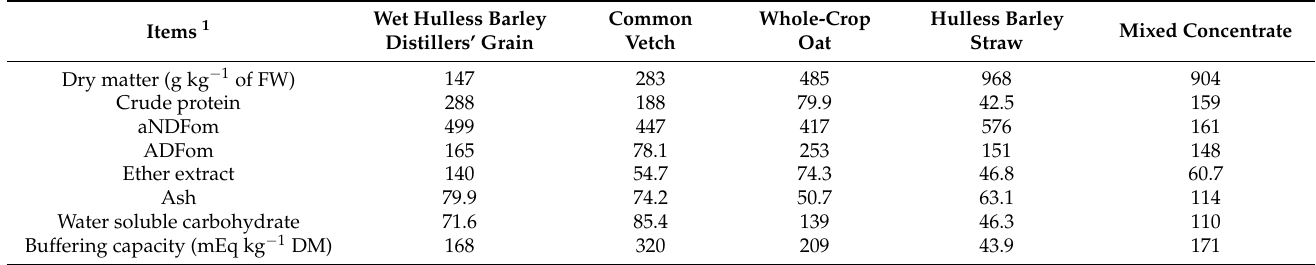
Table 1. Chemical components (g kg − 1 DM, unless otherwise stated) of